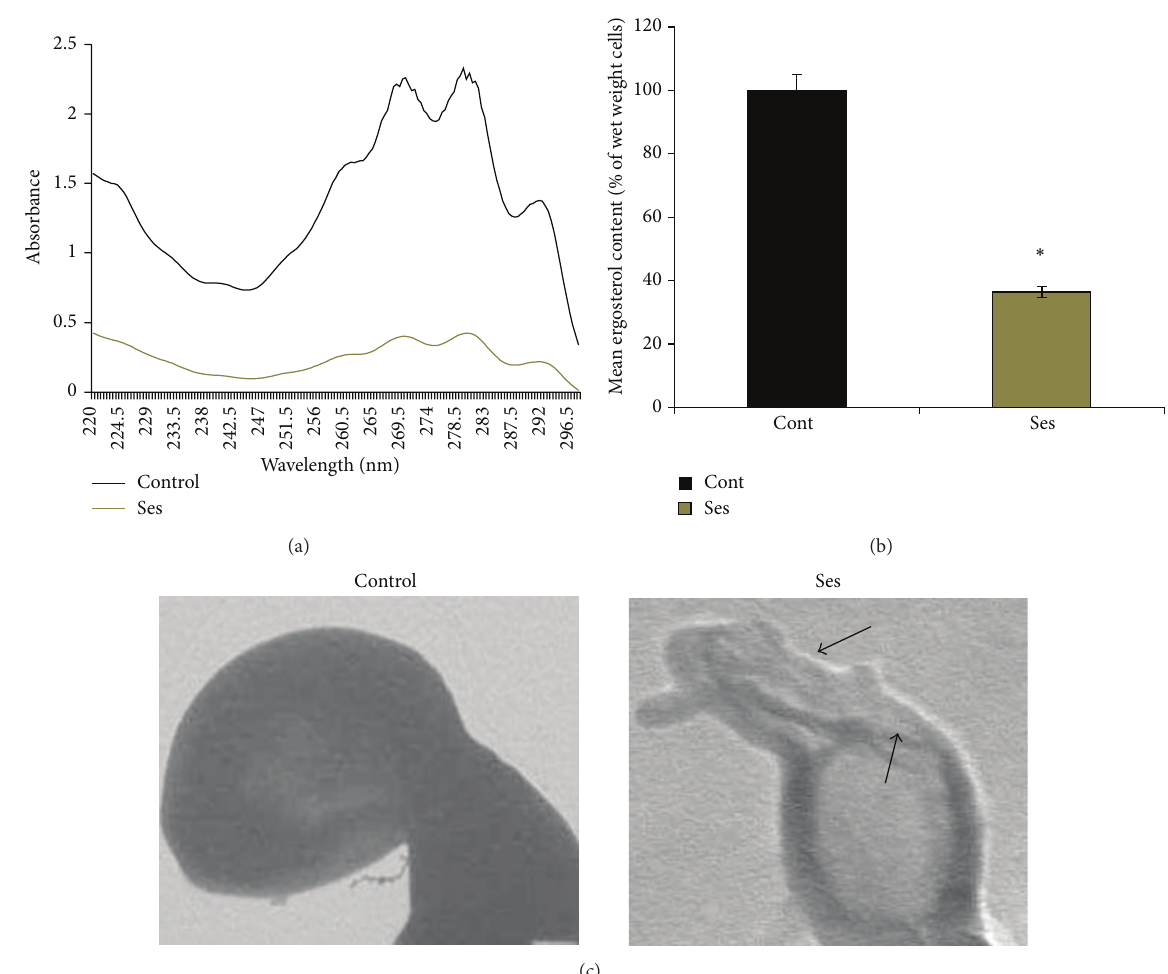
Figure 6: Effect of Ses on membrane composition. (a) UV spectrophotometric sterol profile of C. albicans scanned between 220 and 300 nm from a culture grown for 16 hours with and without Ses (0.552 mg/mL). (b) Relative percentages of ergosterol content in the absence (control) andpresenceofSes(0.552 mg/mL).Meanof%ergosterollevelsiscalculatedasdescribedin Section 2normalizedbyconsideringtheuntreated control as 100 (absolute value of 0.003) ± SD of three independent sets of experiments are depicted on 𝑦 -axis and ∗ depicts 𝑃 value < 0.05. (c) Transmission electron micrographic image showing the tampered membrane integrity of C. albicans with or without Ses as described in Section